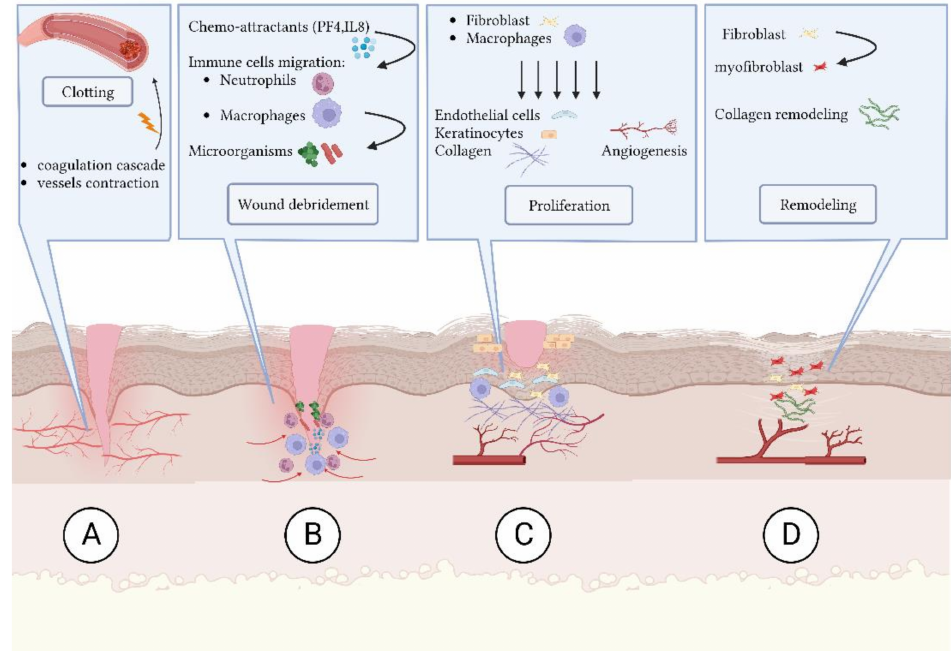
Figure 1. Steps in wound healing process: ( A ) clotting and hemostasis; ( B ) inflammation and debridement; ( C ) proliferation; and ( D ) remodeling. Created with BioRender.com (accessed on 21 October